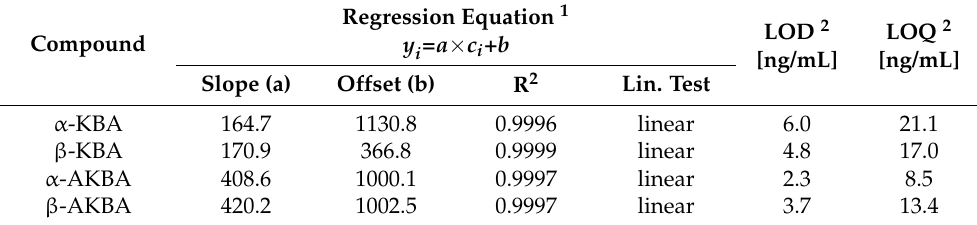
Table A1. HPLC-MS/MS validation data: Regression equation, limit of detection (LOD), and limit of quantification (LOQ).